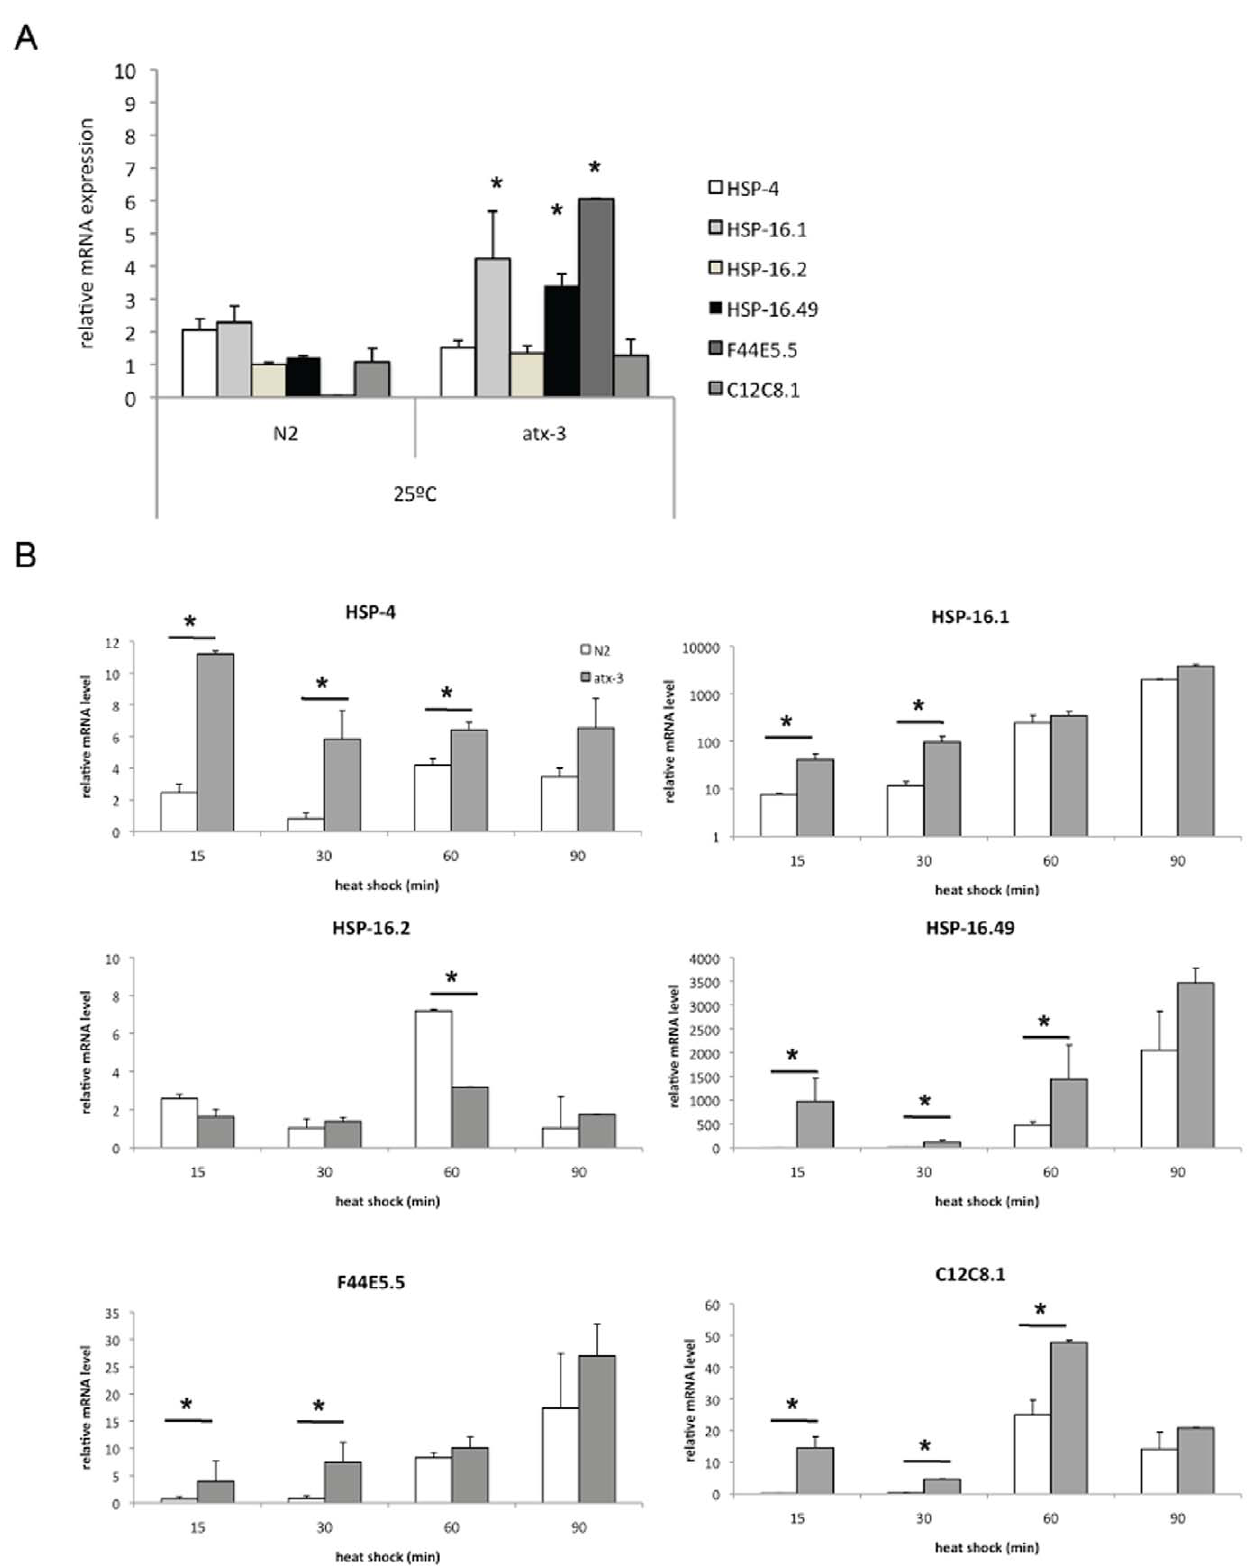
Figure 4. Atx-3 mutants have a lower threshold for induction of heat sock response. ( A ) When grown at 25 u C, atx-3 animals present HSP- 16.1, -16.49 and F44E5.5 up-regulated when compared to control animals (p , 0.05). ( B ) Atx-3 mutants have mRNA up-regulation of several chaperones during the course of heat shock (HS) as measured by Real-Time PCR in young adult animals previously grown at 25 u C. HSP-4 was up- regulated in mutants from 15 until 60 minutes after the beginning of the HS and returned to wild type levels at 90 minutes. HSP-16.1 was only